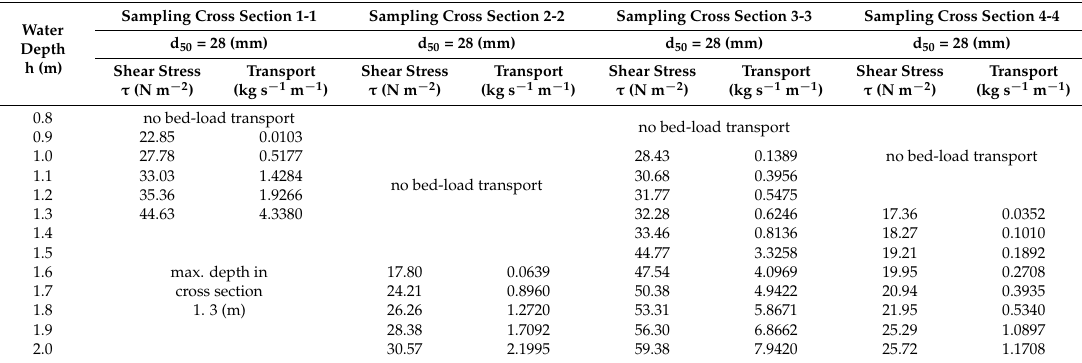
Table 6. Unit bed-load transport at the Lososina River—after the training works. Water Depth